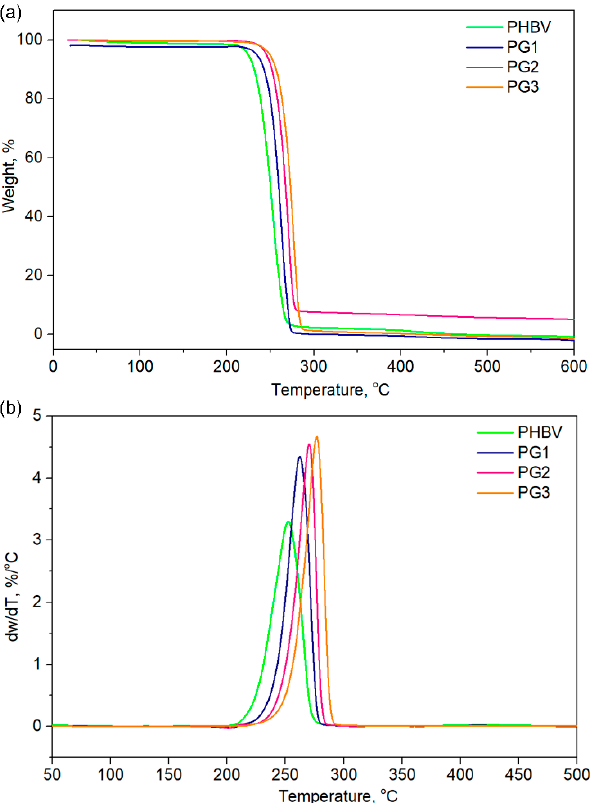
Figure 5. ( a ) TGA and ( b ) DTGA of the pure PHBV biopolymer and film samples with incorporated prodigiosin (PG1-3).